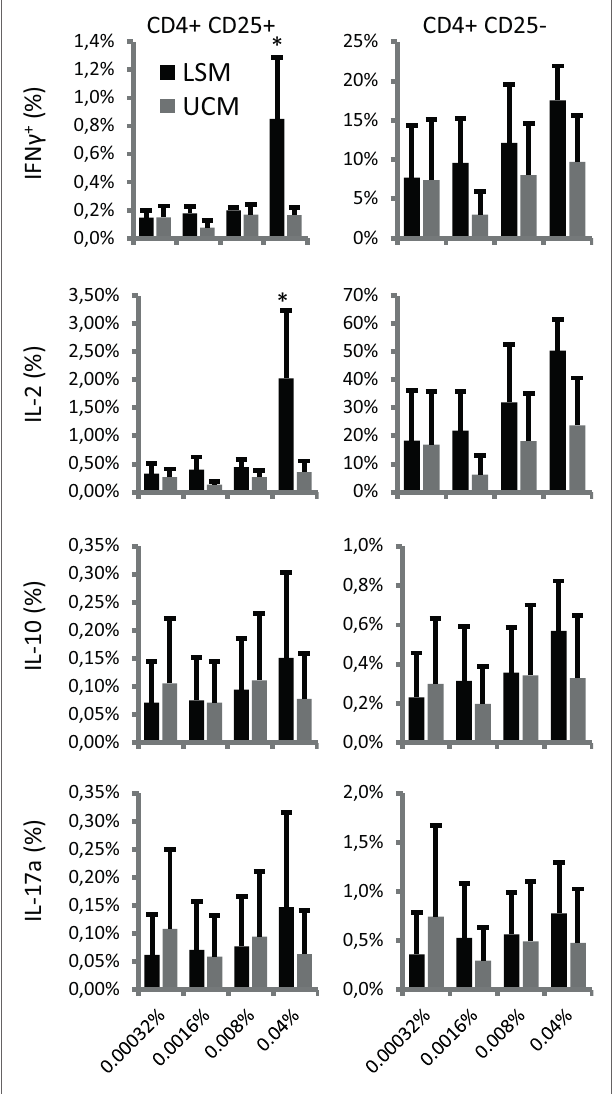
FigUre 4 | LGG soluble mediator (LSM) moDC induce enhanced intracellular cytokine expression in T cells. Intracellular IFN- γ , IL-2, IL-10, and IL-17A expression in CD4 + CD25 + (left panels) and CD4 + CD25 − (right panels) T cells after incubation for 6 days with hemagglutinin and tetanus toxoid pulsed dendritic cells that were differentiated from monocytes in the presence of LSM or UCM. Data are presented as average positive cells of total CD4 + cells of at least three different donors ± SEM (* p < 0.05).